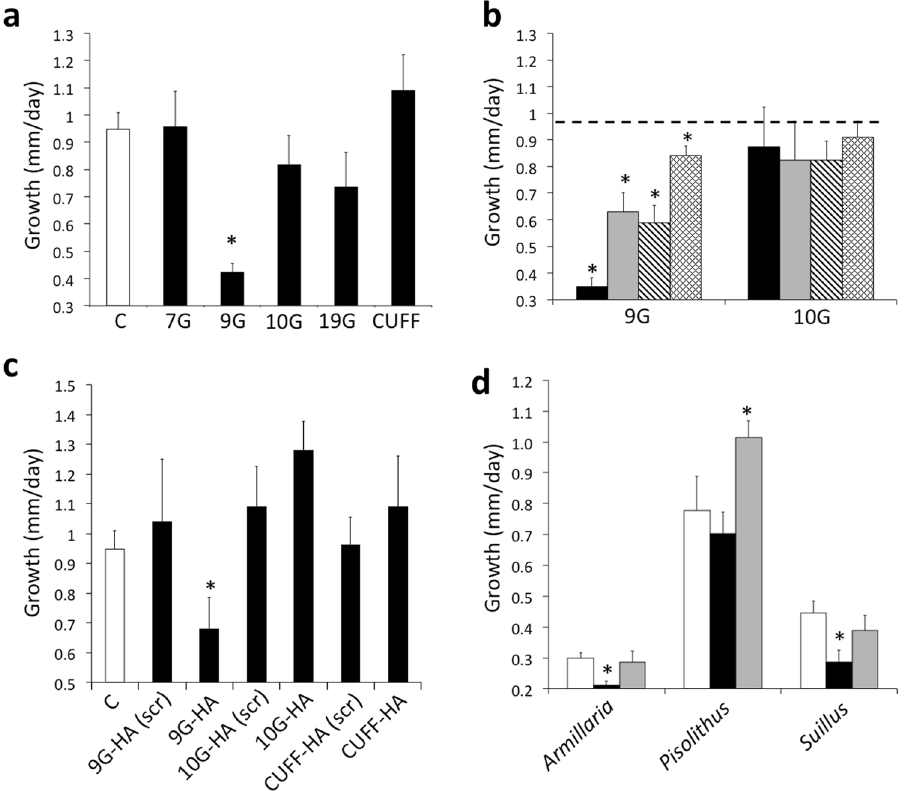
Figure 6. Effect of Populus trichocarpa small secreted proteins (SSPs) on hyphal growth rate. ( a ) Growth rate of L. bicolor hyphae treated with 1 µ M of FITC (C = control), Potri.007G006800 (7G), Potri.009G063200 (9G), Potri.010G251000 (10G), Potri.019G121200 (19G) or with CUFF.29946.1 (CUFF). ( b ) Growth rate of L. bicolor hyphae treated with 1 µ M (black bars), 0.1 µ M (grey bars), 0.01 µ M (diagonal striped bars) or 0.001 µ M (diamond pattern bars) Potri.009G063200 (9G) or Potri.010G251000 (10G) as compared to control treatment (dashed line, 1% DMSO). ( c ) Growth rate of L. bicolor hyphae treated with 1 µ M of either scrambled (scr) or native forms of Potri.009G063200 and Potri.010G251000 labeled with an HA tag as compared to control treatment (‘C’, 1% DMSO). ( d ) Impact of Potri.009G063200 (black bars) and Potri.010G25100 (grey bars) as opposed to control treatment (white bars) on the growth rate of hyphae of three different fungal species ( Armillaria luteobobulina , Pisolithus microcarpus , Suillus granulatus ) ± SE, * Significant difference from control (p < 0.05; Student’s